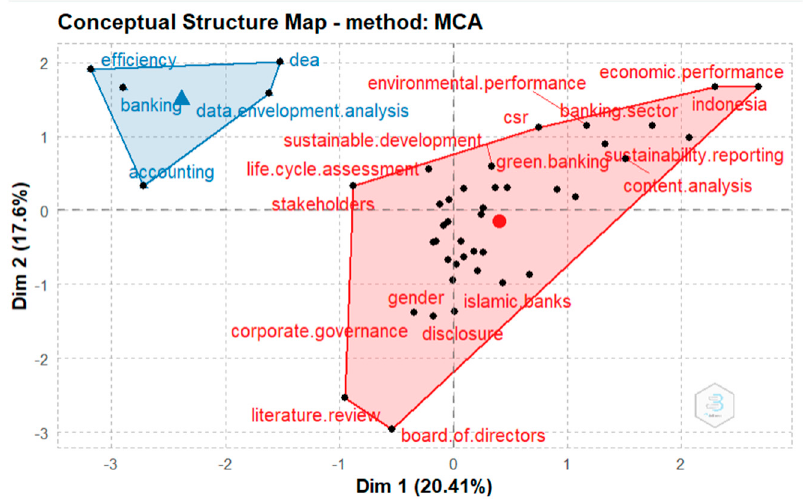
Figure 3. Factorial analysis based on MCA method. Source: Scopus-Biblioshiny.